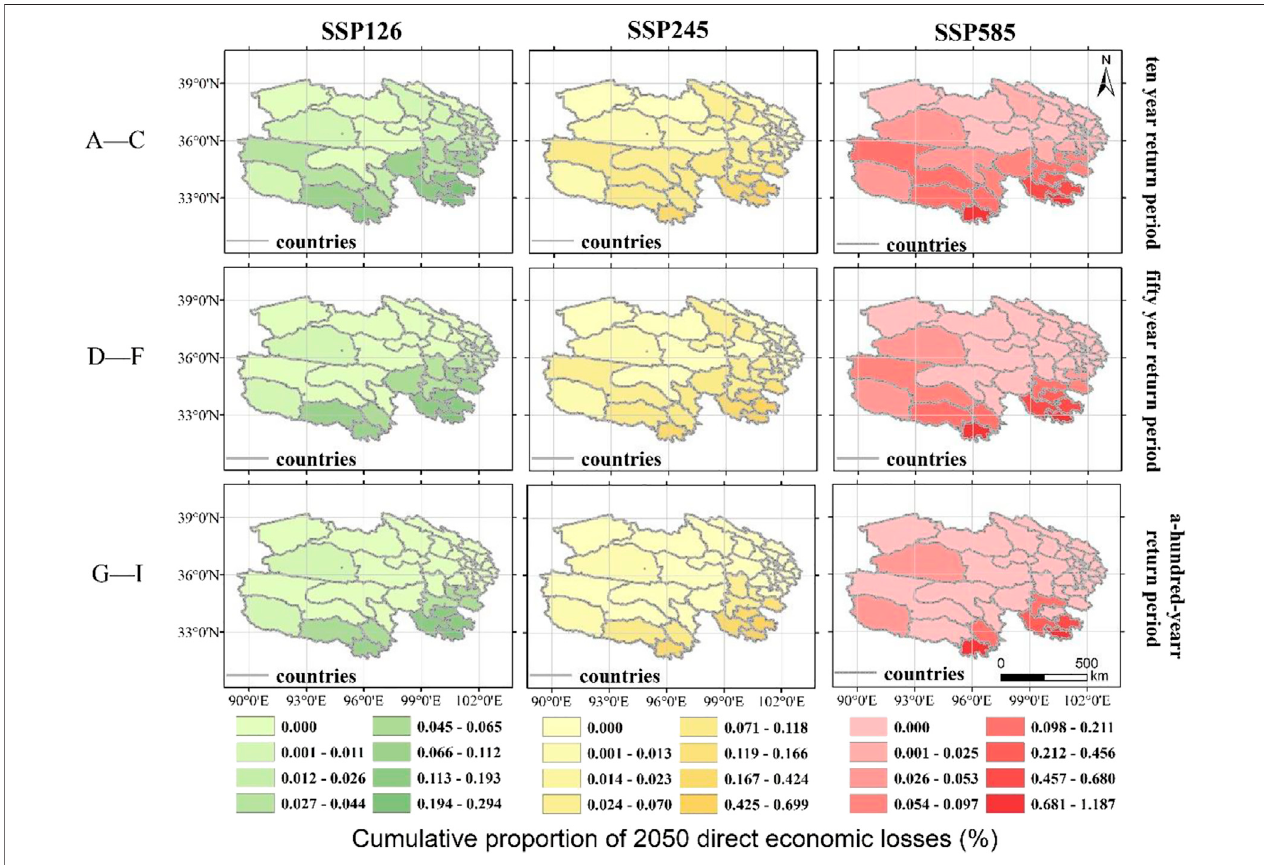
FIGURE7| Spatialdistribution ofthecumulativelossratioofextreme rainstormsand fl ooddisastersinQinghaiprovincein2050. (A – C) countries ’ cumulative fl ood loss ratios of the 10-year return period under three scenarios; (D – F) countries ’ cumulative fl ood loss ratios of the 50-year return period under three scenarios; and (G – I) countries ’ cumulative fl ood loss ratios of 100-year return period under three